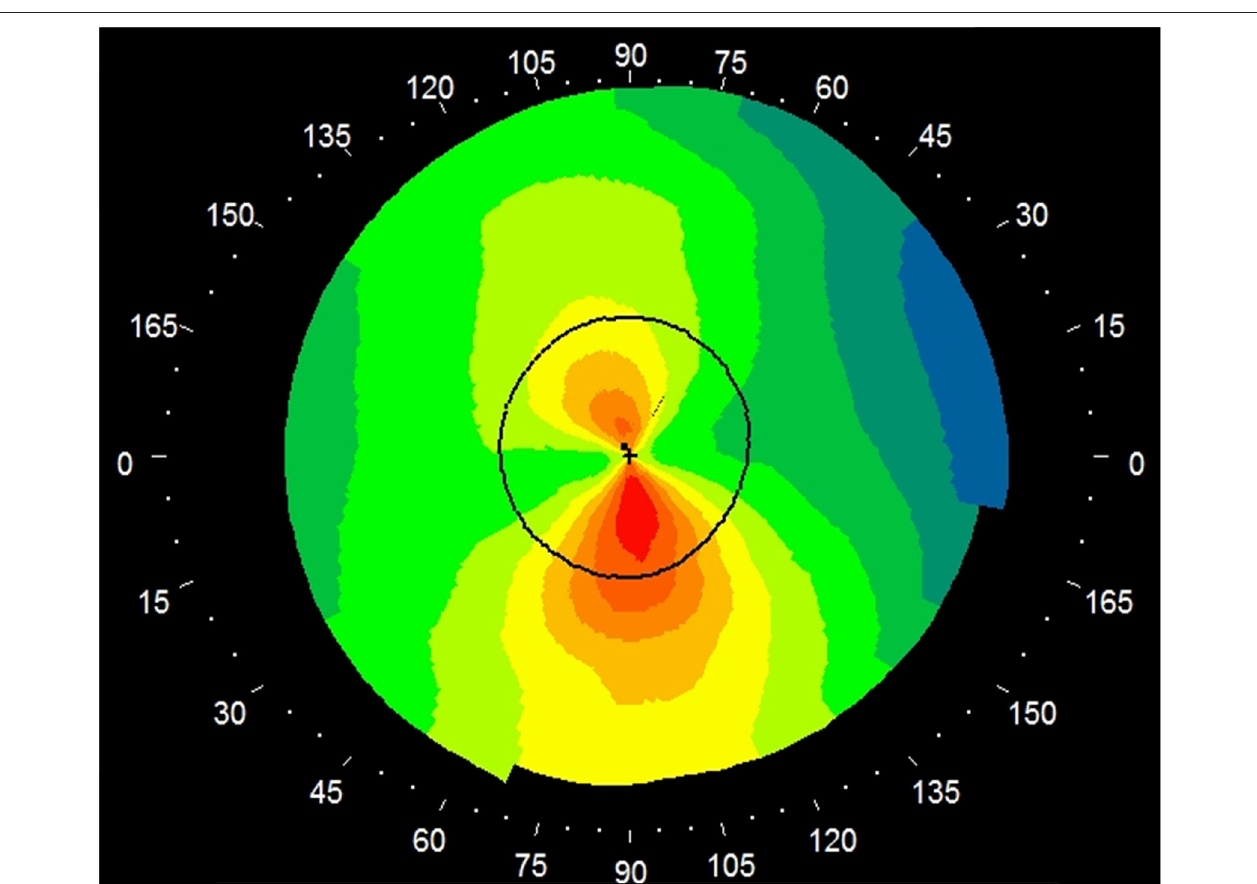
FIGURE 1 | A representative image of a single color-coded map (absolute axial map) by the Placido disk-based corneal topography. A color-scale bar was eliminated for deep learning.